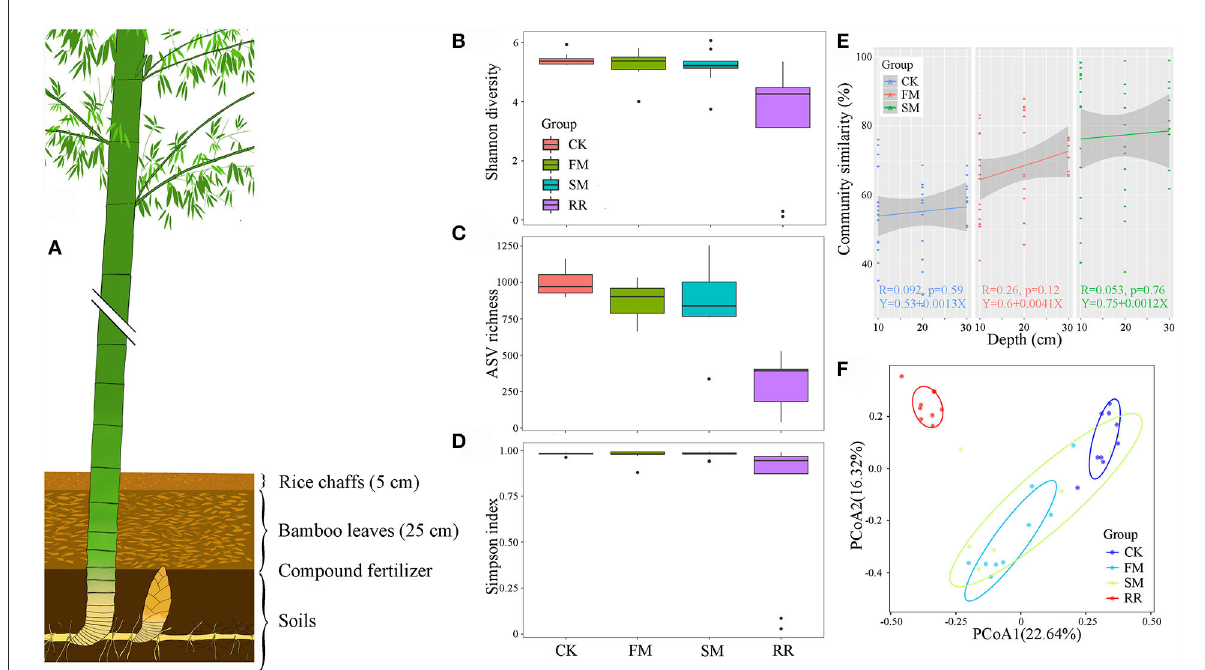
FIGURE1 A diagram of combined intensive management of Moso bamboo forests (A) and its effect on the diversity and composition of Moso bamboo rhizome roots and soil bacteria. (B) Shannon diversity, (C) ASV richness, and (D) Simpson index were calculated with 999 permutations in R v . 3.6.1 (R Core Team, 2019). Box plots showed the range of estimated values between 25% and 75%, the median, the minimum, and the maximum observed values within each dataset. (E) The similarity of soil bacterial communities under different management periods across soil depth. The lines denote the least-squares linear regressions across soil depth, with 95% confidence intervals (gray-shaded areas). (F) Principal coordinates analysis (PCoA) of bacterial community composition among different groups based on the Bray–Curtis dissimilarity matrix performed by the online tool iSanger (https://cloud.majorbio.com). Ellipses cover the data for each group.